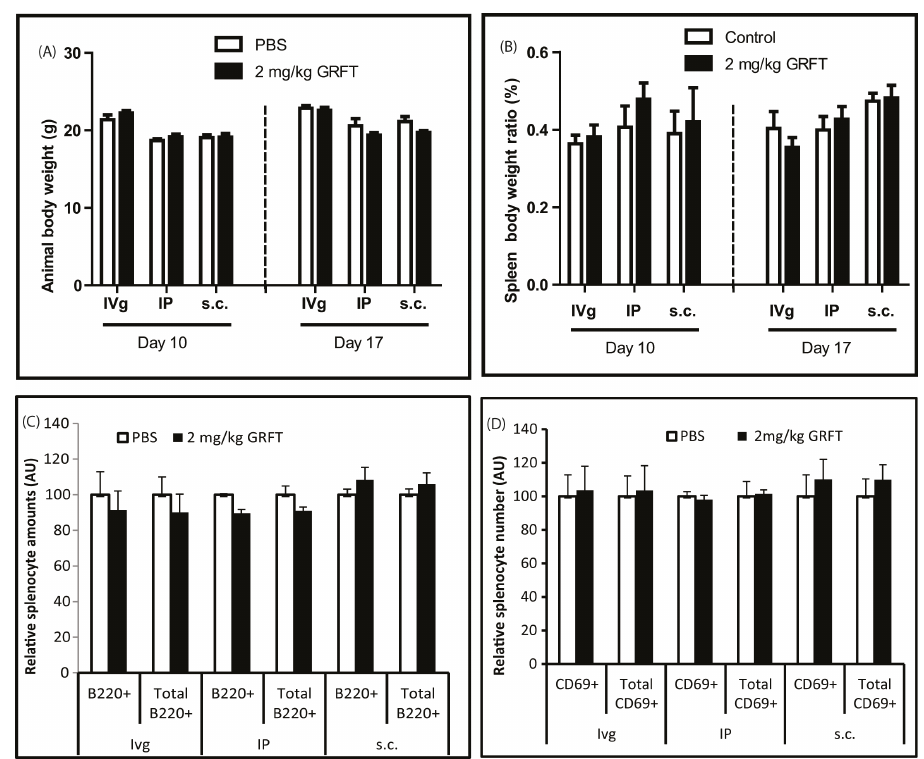
Figure 6. Safety of a chronic dose of 2 mg/kg GRFT in mice. Mouse body ( A ) and spleen ( B ) weights were assessed after 10 daily s.c., intravaginal, and intraperitoneal administrations, respectively, of GRFT at 2 mg/kg or PBS; In addition, immune cell activation of splenocytes from these mice was evaluated by flow cytometry after dual fluorescent staining with FITC-conjugated anti-CD4 or CD19 mAb in combination, respectively, with PE-conjugated anti-B220 ( C ) or anti-CD69 ( D ). B220+, cells staining positive for B220 only (single positive); Ttotal B220+ represent B220 single positive and B220/CD19 double positive.